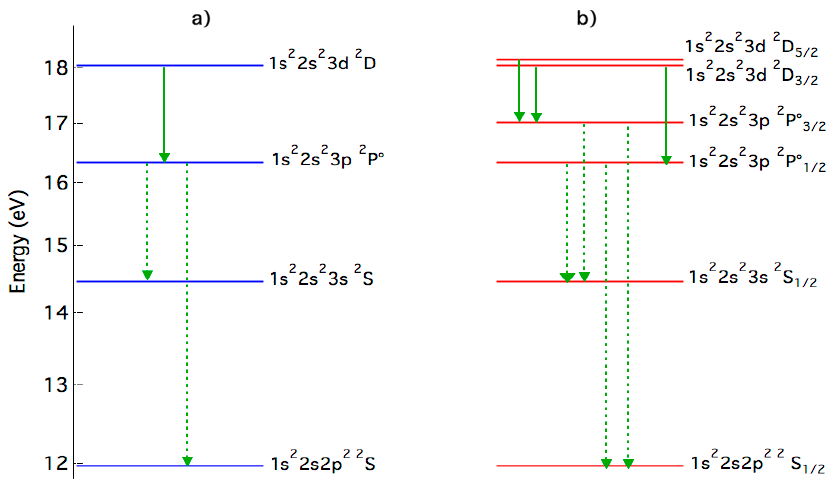
Table 1. Summary of the atomic data of the 1s 2 2s 2 3s 2 S-1s 2 2s 2 3p 2 P° and 1s 2 2s 2